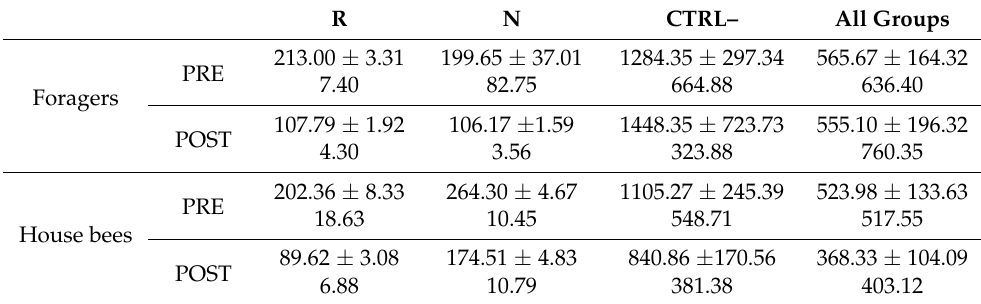
Table 2. N. ceranae abundance (average ± standard error, standard deviation) registered in the pre- and post-treatment samples from the different groups of treatment. R N CTRL– All Groups